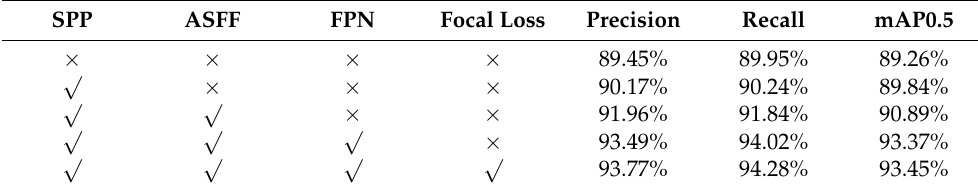
Table 4. Results of ablation experiments.